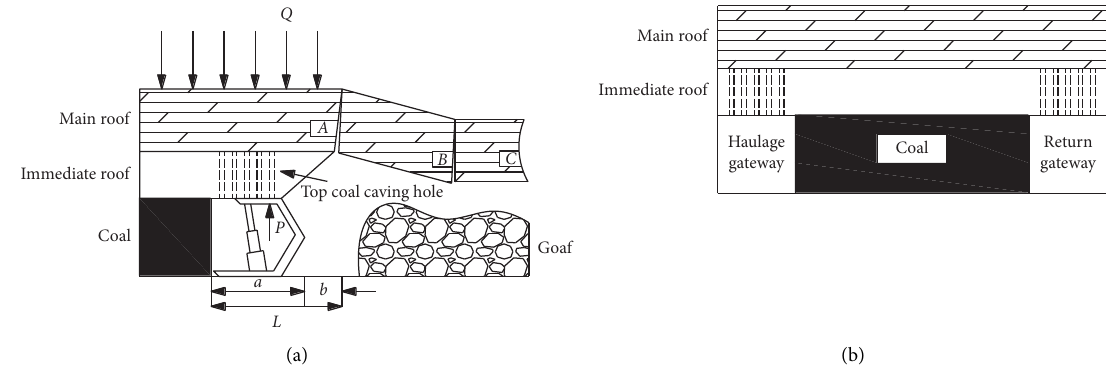
Figure 3: Mechanical model of roof pressure